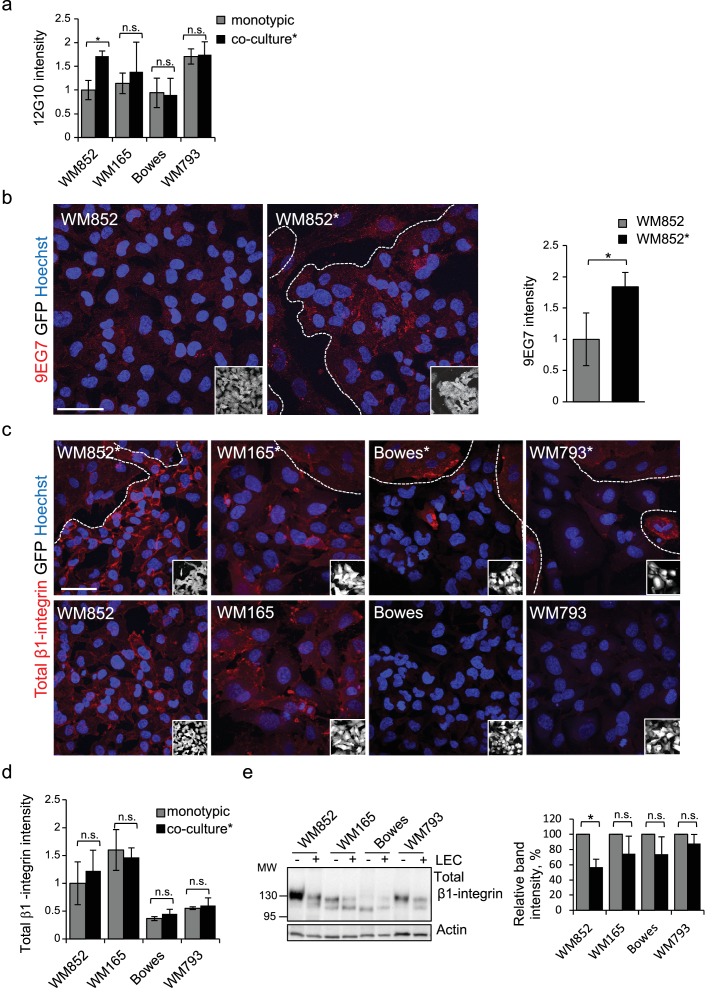
Quantification of active and total β1-integrin in monotypic and LEC-primed melanoma cells.(a) Quantification of active β1-integrin (12G10) intensity in the indicated melanoma cell lines from monotypic cultures or after co-culture with LEC (*). Average of the intensity was calculated in four images/condition from two independent experiments. More than 100 cells were always analysed per condition. Error bars indicate SD, *: p<0.05; n.s., non-significant. (b) Left and middle panels: representative confocal images of WM852 and WM852* stained with 9EG7 antibody for active β1-integrin (red). Nuclei were counterstained with Hoechst 33342 (blue). Dashed line indicates LEC-melanoma border. Scale bar = 50 µm. Right panel: quantification of 9EG7 intensity in the indicated cell types performed as in (a). (c) Representative confocal images of β1-integrin staining (red) in the different GFP expressing melanoma cell lines (GFP positive cells white in the inset) cultured in the presence (*, upper panels) or absence (bottom panels) of LECs. Nuclei were counterstained with Hoechst 33342. The dashed line indicates the LEC-melanoma (below the line) border. Scale bar = 50 µm. (d) Quantification of total β1-integrin intensity in the indicated melanoma cell lines from monotypic cultures or co-cultured with LEC (*) as described in (a). n.s., non-significant (e) Left panels: Immunoblot of indicated cell lines derived from monotypic or LEC co-cultures and separated by magnetic separation prior to sample preparation and stained with the indicated antibodies. Right panel: Percentages of β1-integrin intensities normalized to actin from two independent experiments. Error bars indicate SD; *: p<0.05; n.s., non-significant. Full size confocal images are available as a source data 4.